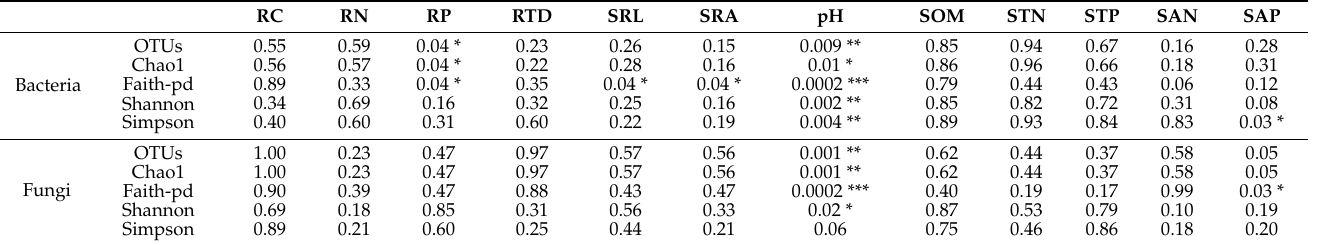
Table 3. Fine root functional traits and the correlation between rhizosphere soil and soil microbial community diversity.